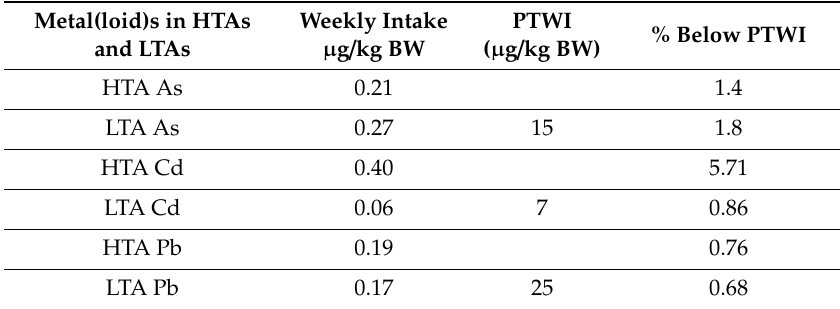
Table 5. Summary of dietary exposure to As, Cd, and Pb from a 5 g intake of tea 1.54 days per week comparing the PTWIs of HTAs to LTAs.